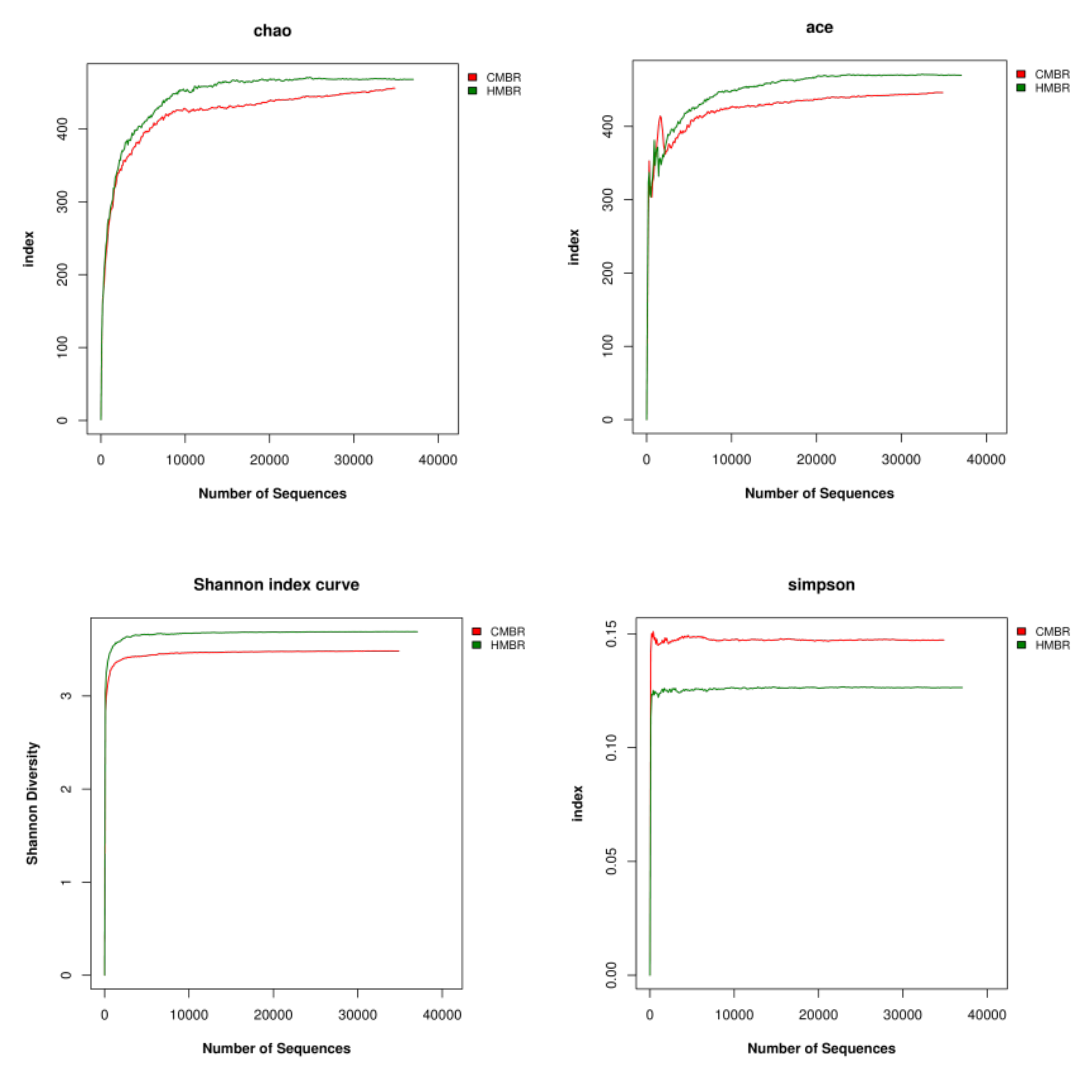
Figure 7. Several index curves about microbial community in CMBR and HMBR.